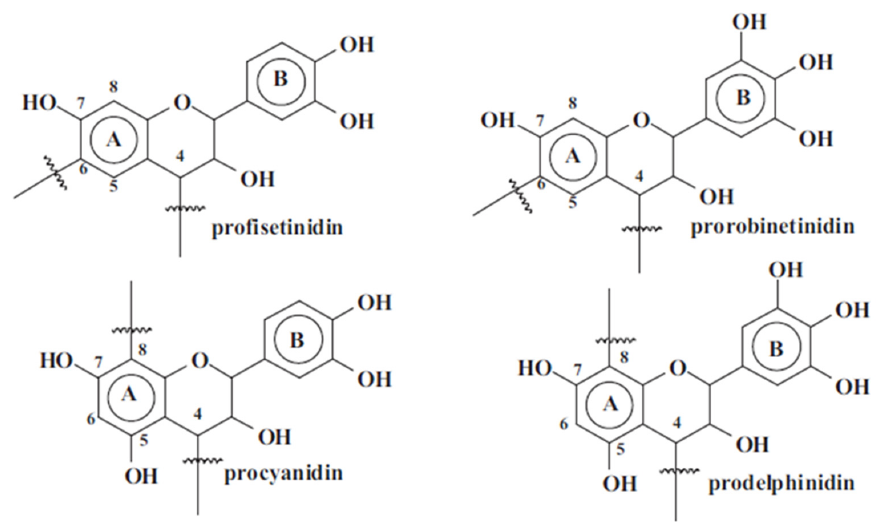
Figure 11. Tannin types: profisetinidin (quebracho), prorobinetinidin (mimosa), and prodelphinidin and procyanidin (pine) [80].